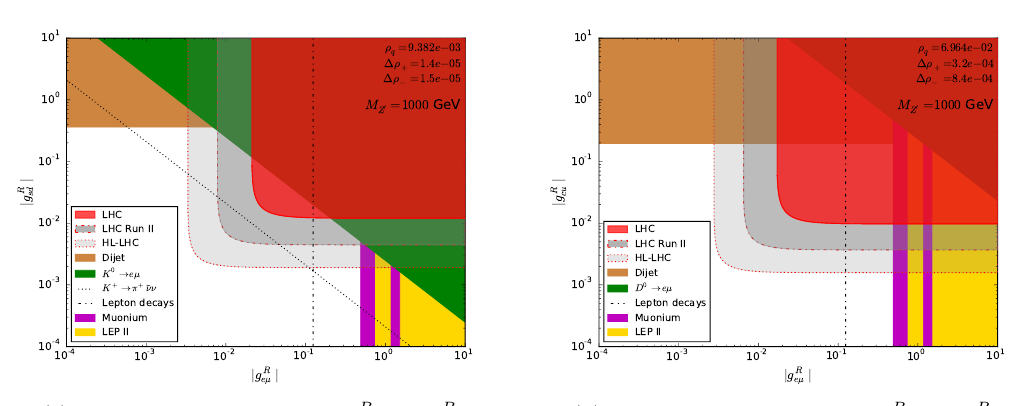
Figure 20 . Flavor-violating couplings in the e(cid:22) sector for a Z 0 boson of M Z 0 = 1 TeV. The red areas depict the limits from the ATLAS analysis of the process pp ! e(cid:22) at dash-dotted and dashed lines are projections to the LHC Run II and HL-LHC. The brown areas show four-quark contact interaction limits from LHC dijet analyses [15]. The green areas are the limits coming from meson decays into charged leptons. The gold and magenta areas are purely leptonic limits coming from LEP and muonium oscillation constraints. The black dotted lines are meson decay limits into neutrinos and the black dash-dotted line the limits from lepton decays. These last two limits, however, apply only for left-handed lepton couplings g L meson decay limits into neutrinos are absent in the cu sector